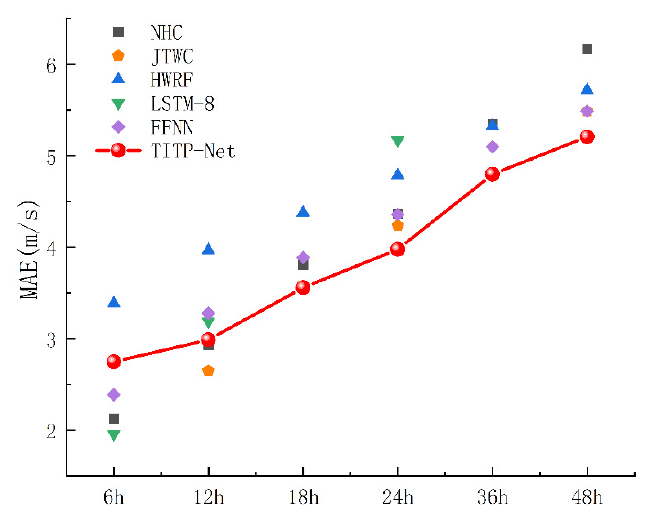
Figure 11. Evaluation of the MAE metrics of official agencies and other scholar results in 6 h, 12 h, 18 h, 24 h, 36 h and 48 h prediction. Each point represents the forecasting MAE at 6–48 h by different methods. The red point plot represents the results in various hours prediction of TITP-Net.